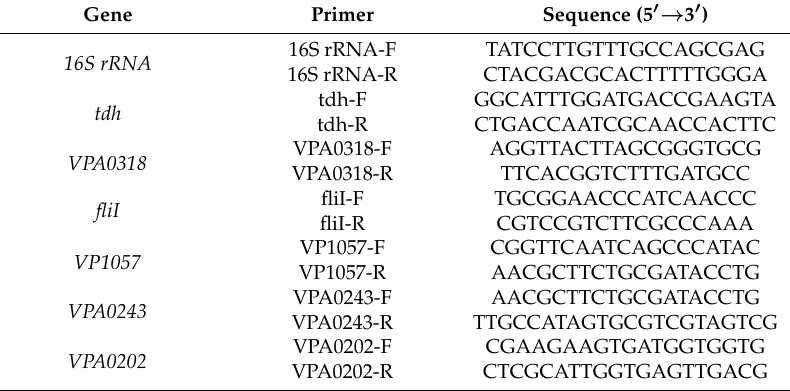
Table 1. Primers used to verify gene expression level by quantitative real-time polymerase chain reaction